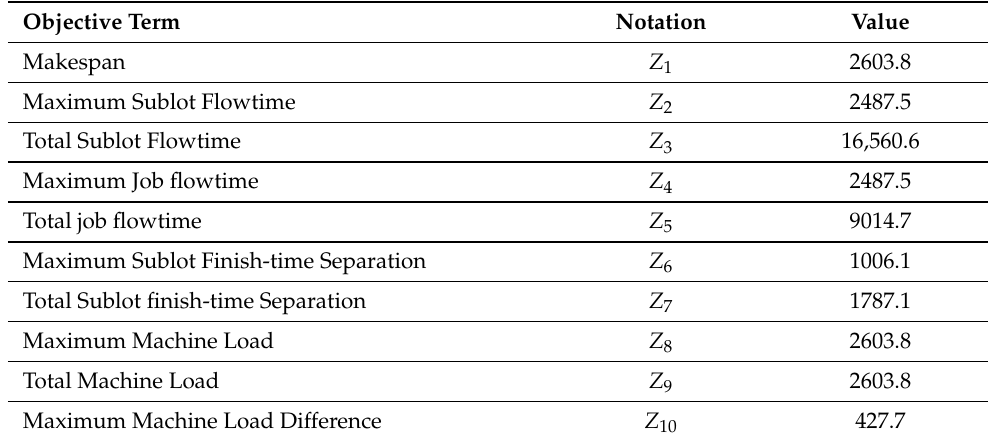
Table 9. Values of the objective function